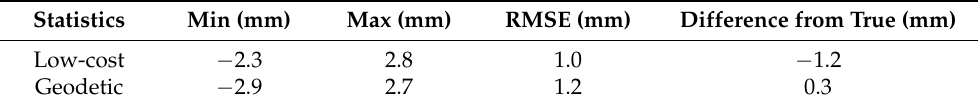
Table 7. The horizontal distance statistics for low-cost instruments ( receiver : ZED-F9P; antenna : Survey Calibrated) and geodetic instruments ( receiver : Leica GS18; antenna : LEIGS18).